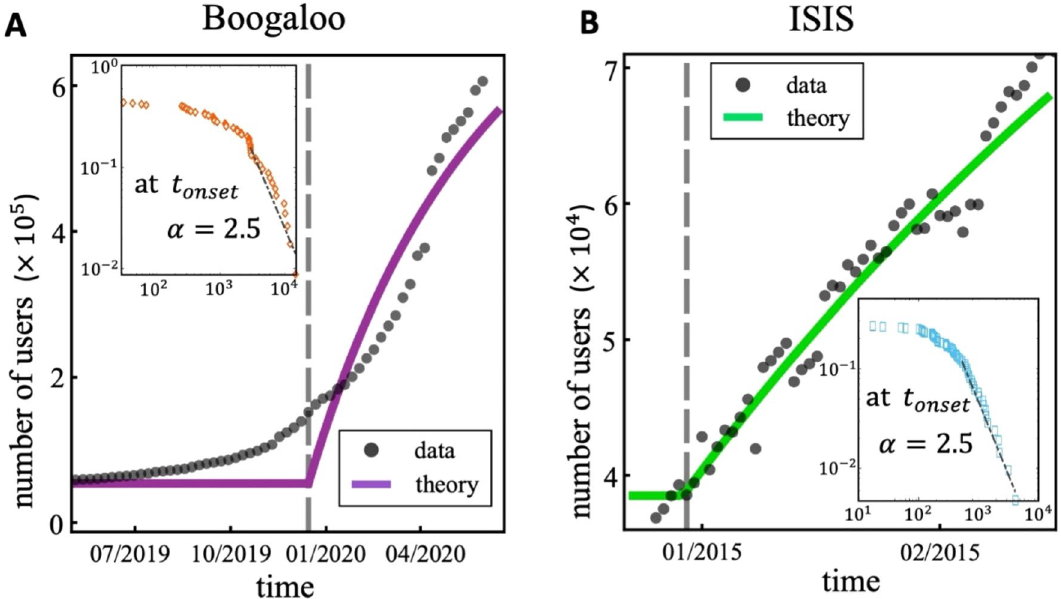
Figure 5. ( A,B ) Growth curves of the overall Boogaloo movement (size is the combined number of users in their Facebook Pages), and the entire ISIS movement (size is the combined number of users in their VKontakte Groups). Insets show distribution of sizes of the individual groups at the predicted onset t onset (vertical gray line in main panels). The maximum-likelihood estimate for the magnitude of the negative power-law exponent in each case is 2.5 to two significant figures, which is the same value as predicted by our mathematical theory (SI Sect. 2.7, Eq. (23)). The rigorous statistical analysis that we follow to obtain these results, is given in SI Sect.